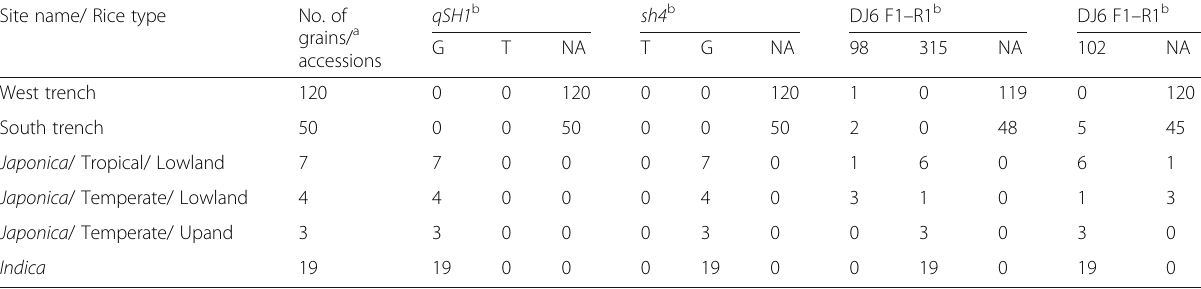
Table 4 DNA genotype of archaic grains and modern rice accessions by specific primer set in the nuclear genome Site name/ Rice